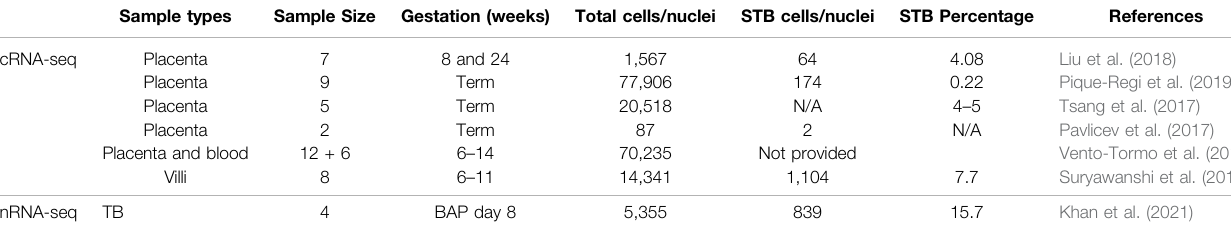
TABLE 1 | Comparison of STB percentage among samples analyzed by scRNA-seq or snRNA-seq. Sample